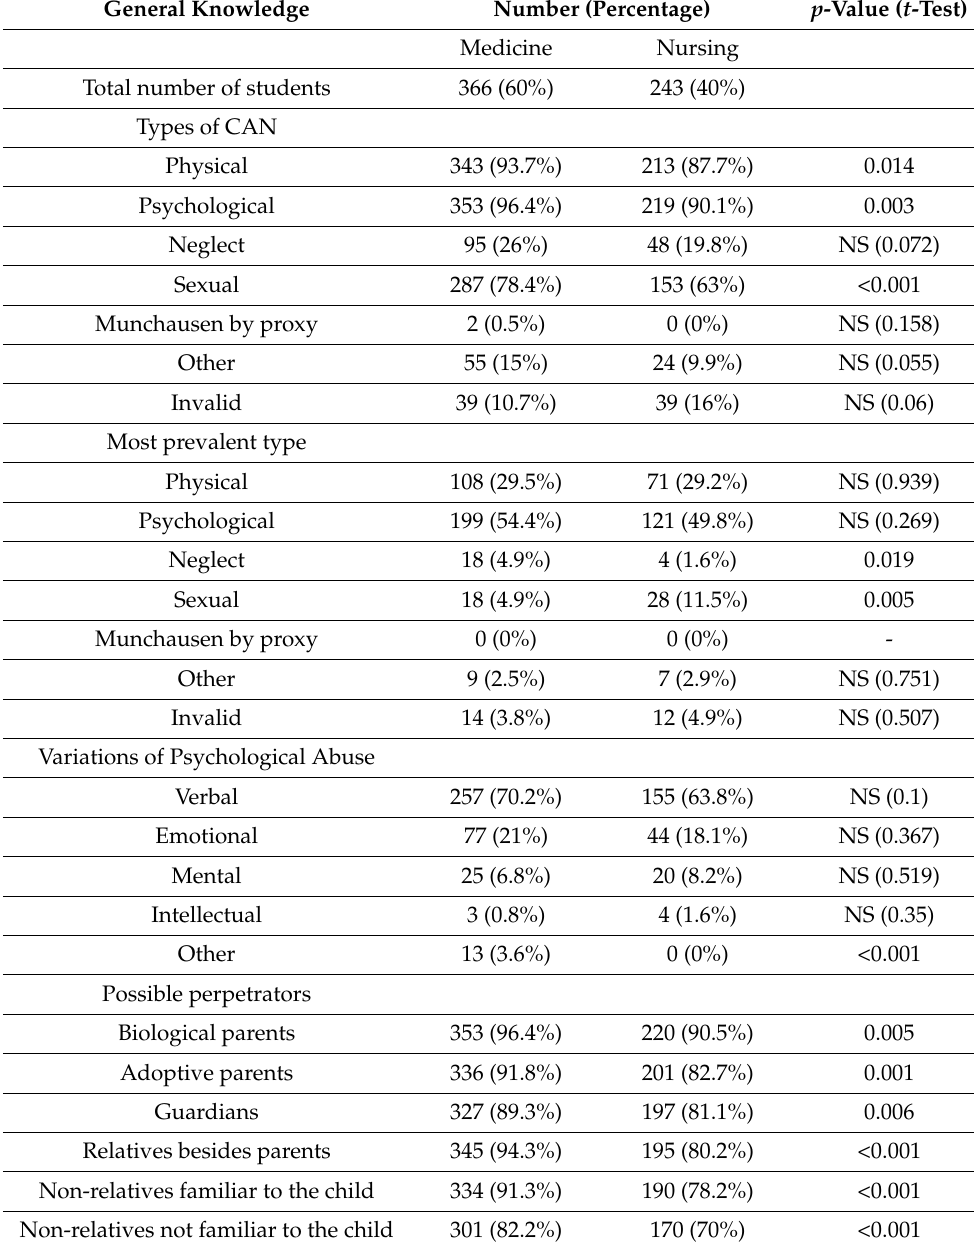
Table 2. General knowledge of the study population regarding CAN ( n = 609).